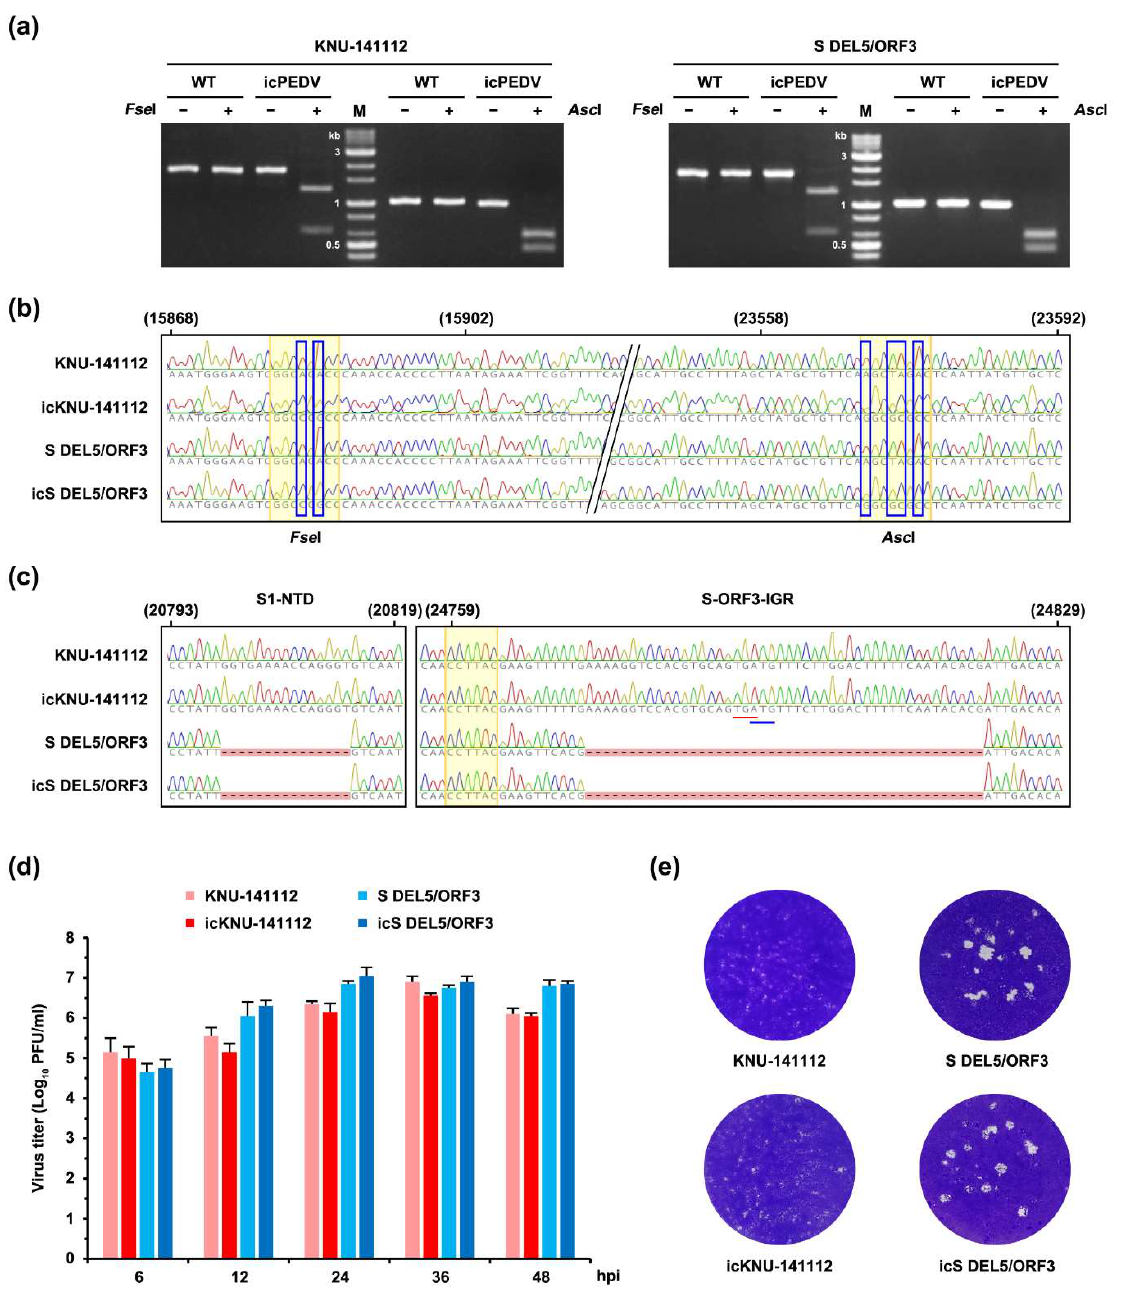
Figure 3. Genotypic and phenotypic characteristics of icKNU-141112 and icS DEL5/ORF3. ( a ) Confirmation of marker mutations in the rescued virus. Silent mutations were introduced to create two Fse I and Asc I sites at genomic positions 15880 and 23570/23555 (first nucleotide of the recognition sequence), respectively. Viral RNA was extracted from cells infected with each virus and subjected to RT-PCR analysis using primers covering each restriction site. Two 1800-nt and 1000-nt RT-PCR amplicons obtained from the parental (WT) and rescued (icPEDV) viruses of KNU-141112 (left panel) and S DEL5/ORF3 (right panel) were subsequently analyzed by Fse I and Asc I digestion and agarose gel electrophoresis. M, molecular mass marker (1-kb DNA ladder). ( b ) The sequence chromatograms of partial fragments (genomic positions 15868–15920 and 23542–23592) of the parental (KNU-141112 and S DEL5/ORF3) and rescued (icKNU-141112 and icS DEL5/ORF3) viruses. The Fse I and Asc I recognition sites are highlighted in yellow. The differences between the parental and res- cued viruses are indicated by blue boxes. ( c ) Sequence analysis of the parental and rescued viruses at the genotypic DEL signatures in NTD of S and IGR between S and ORF3 of S DEL5/ORF3. The sequence chromatograms of partial fragments (genomic positions 20793–20819 and 24756–24829) of